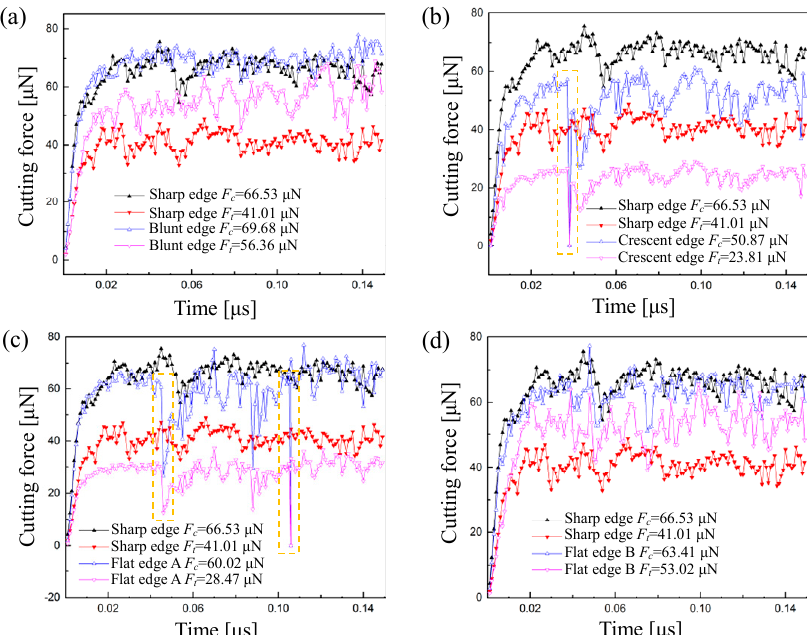
Figure 10. Curves of cutting force vs. time history in simulations: ( a ) comparison of blunt edge and sharp edge; ( b ) comparison of crescent edge and sharp edge; ( c ) comparison of flat edge A and sharp edge; ( d ) comparison of flat edge B and sharp edge (the average results of forces are noted in the legends).